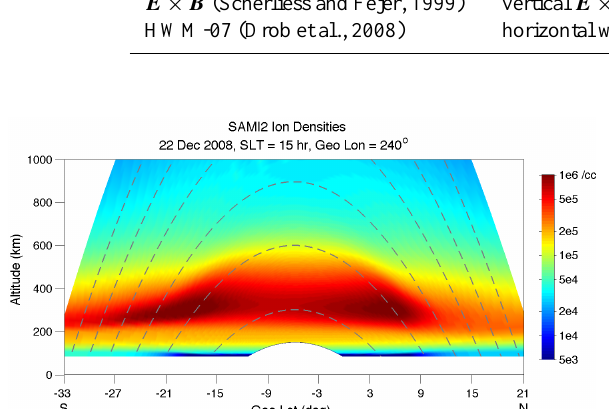
Table 1. The empirical models used to drive the physics in SAMI2 and the changes applied for extreme solar minimum. Model Fig. 1. The afternoon ion densities as predicted by SAMI2 for a two-dimensional stack of geomagnetic field lines near 240 degrees geographic longitude. The dashed lines represent field lines every 300 km.